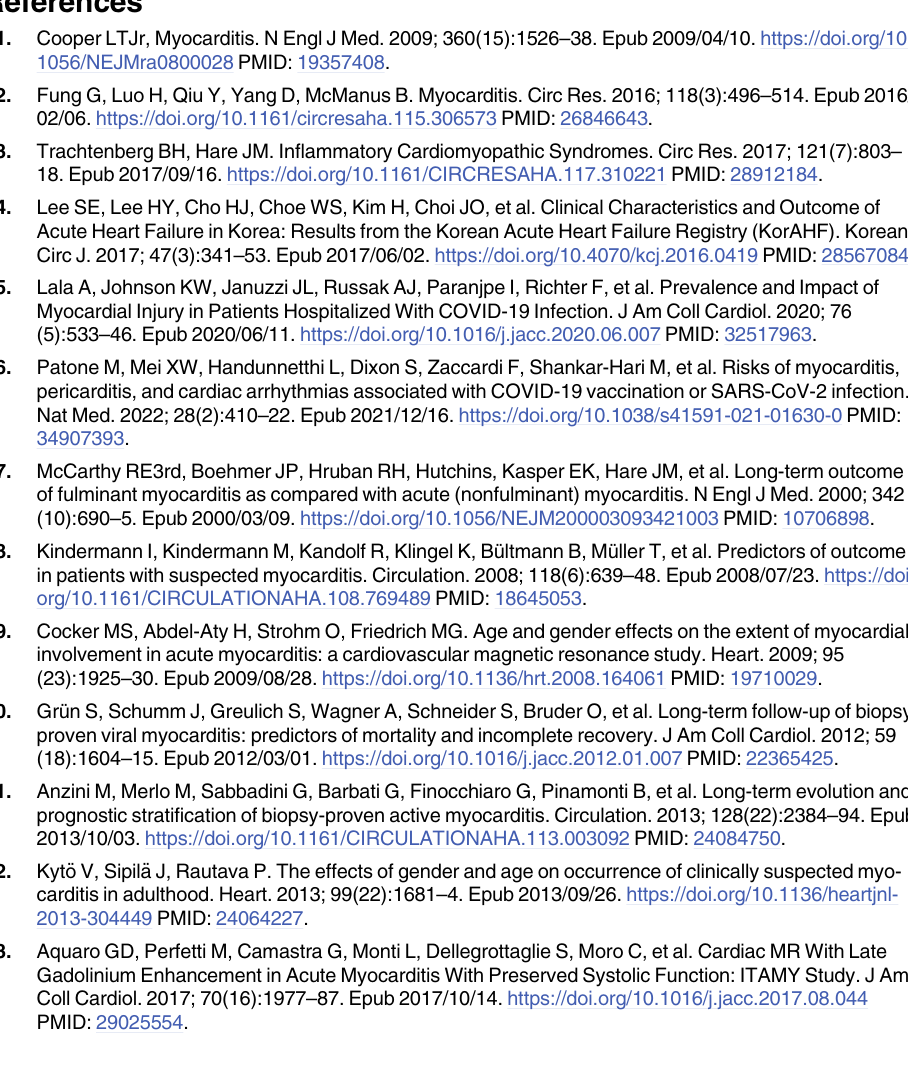
S3 Fig. Cardiovascular mortality according to differential age groups. (TIF) S1 Table. The annual incidence of suspected acute myocarditis during the study